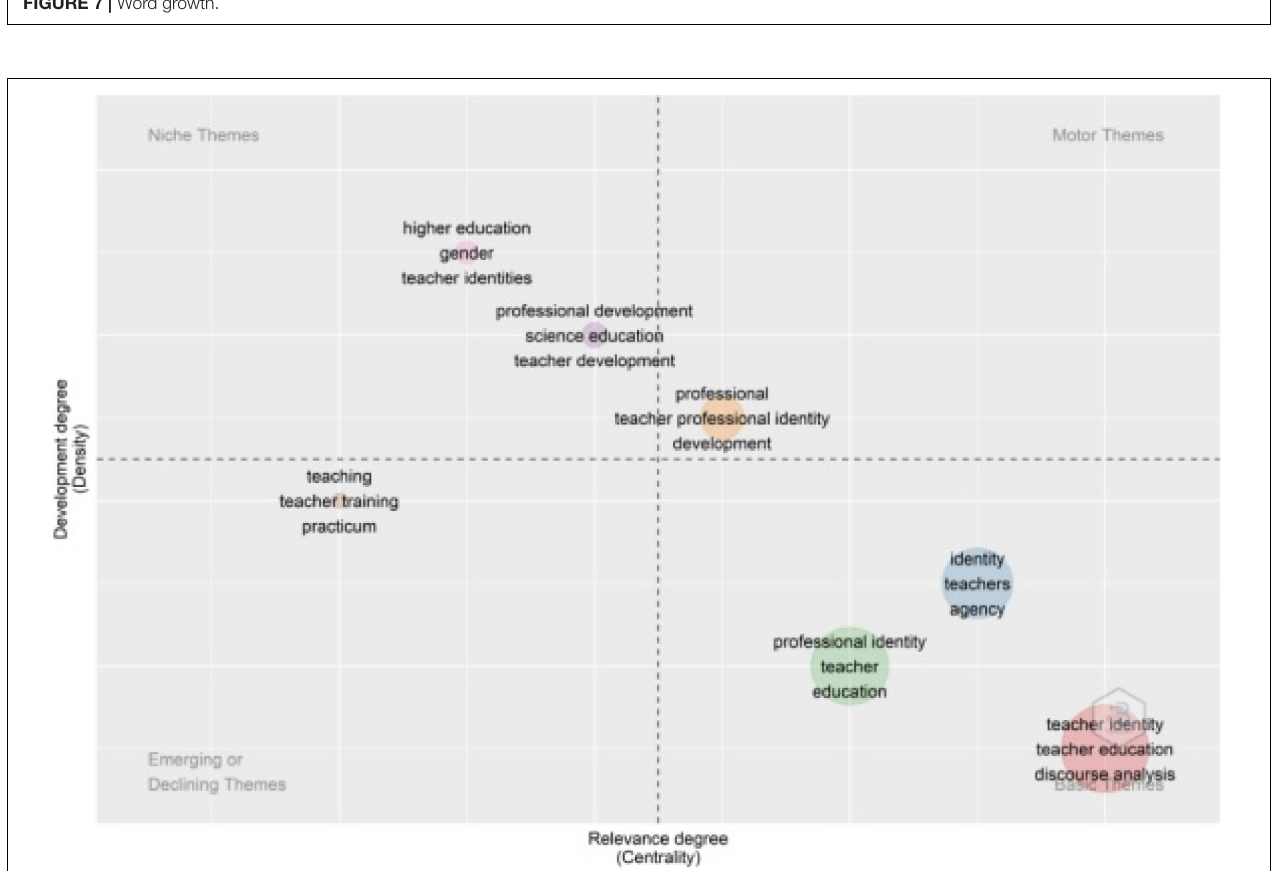
FIGURE 8 | Thematic